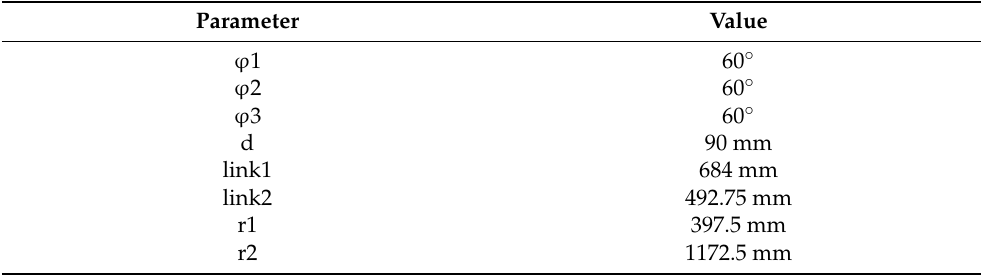
Table 1. PKM structure configuration parameters.